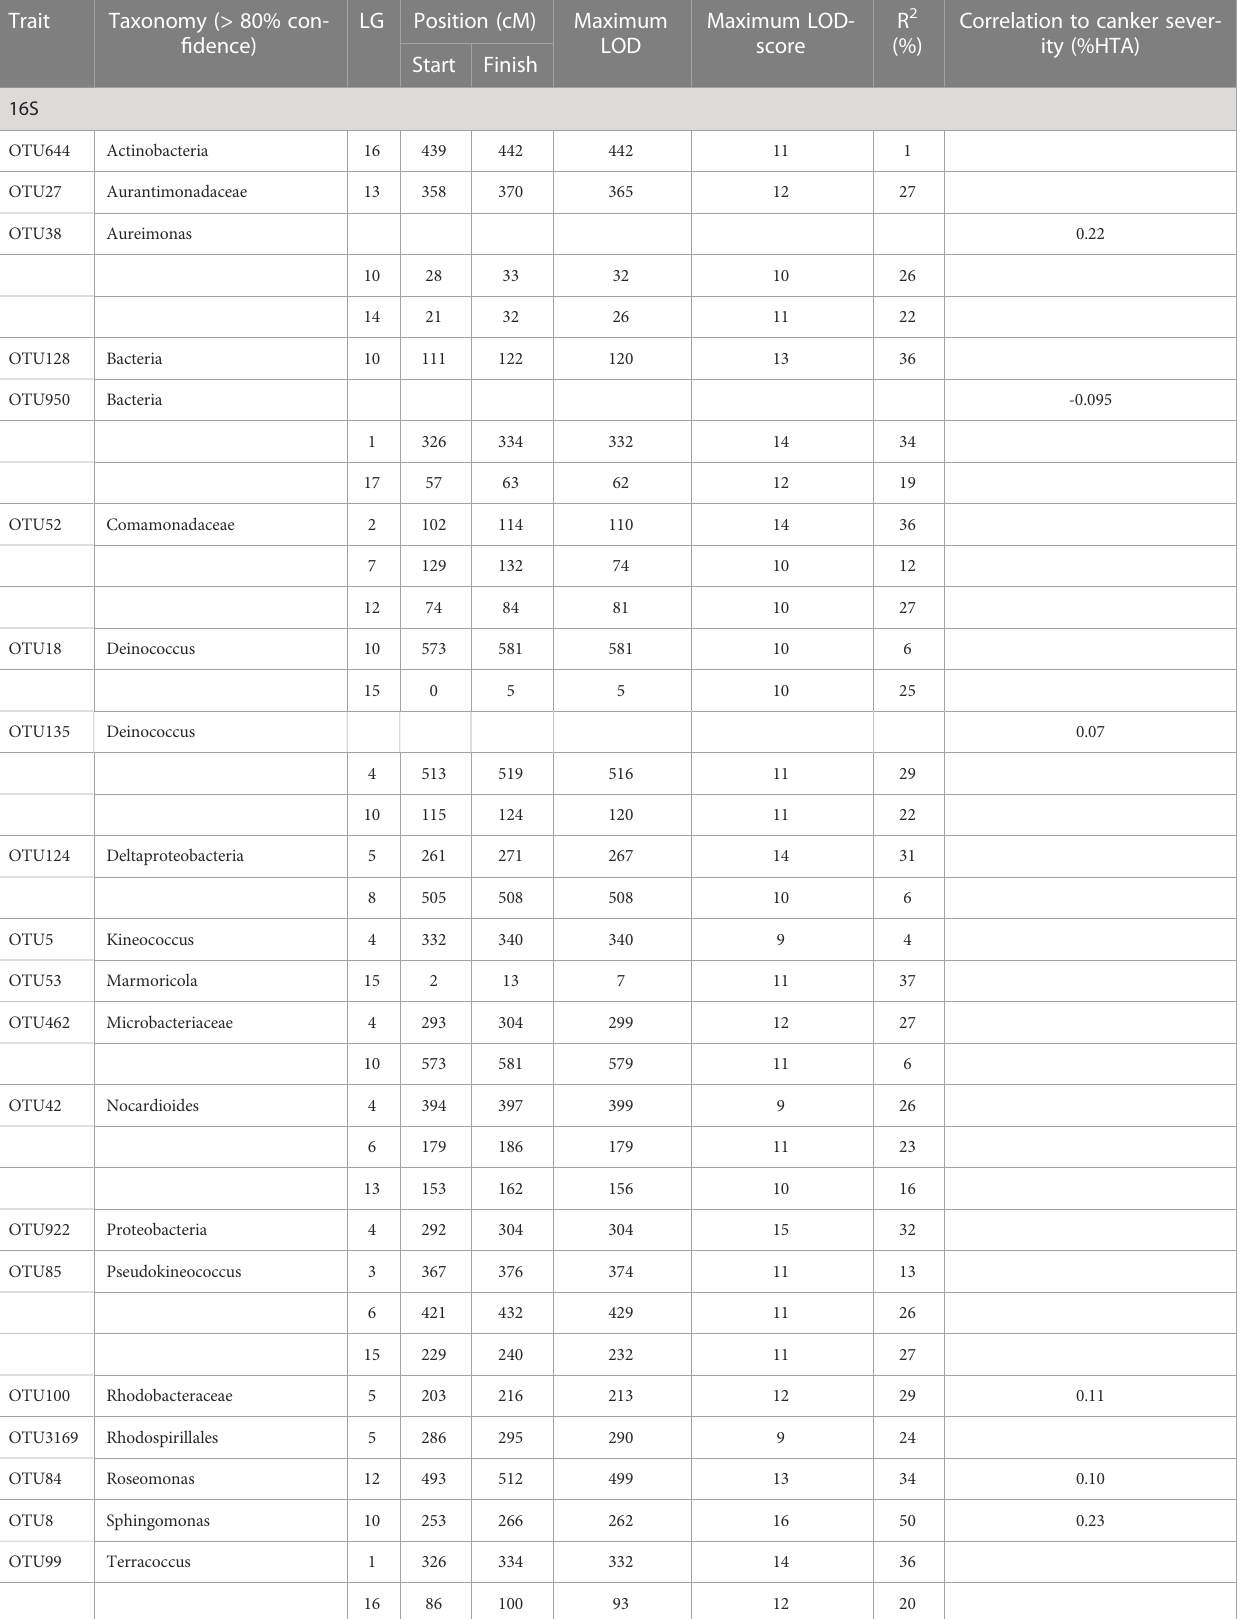
TABLE 1 Quantitative trait loci (QTL) composite interval mapping for abundance data of bacterial (16S) and fungal (ITS) endophytes in apple leaf scar tissues of a full-siblings mapping population of a ‘ Aroma ’ x ‘ Golden Delicious ’ cross.